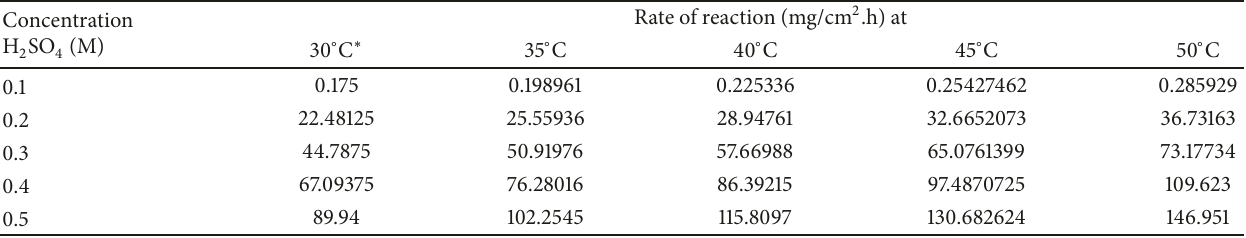
Table 3: The rate of reaction (mg/cm 2 .h) of mild steel in sulfuric acid at different concentration (0.1-0.5 M) and at different temperature (30-50 ∘ C).